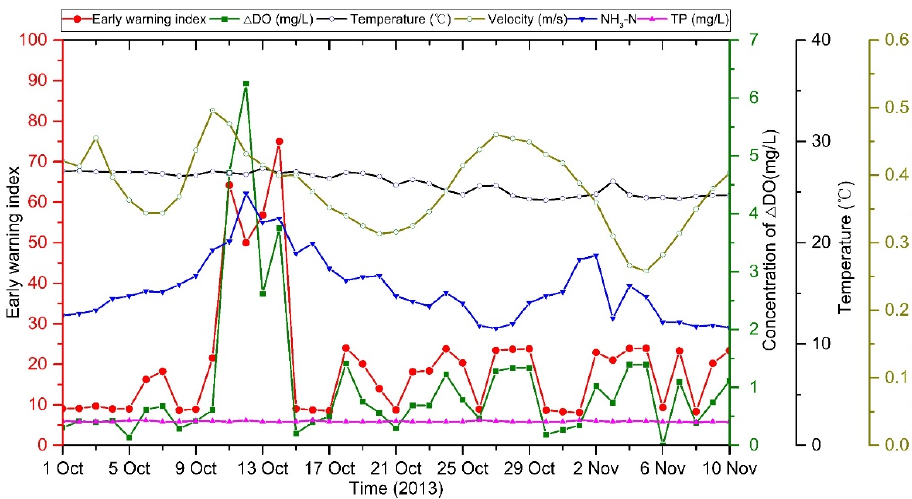
Figure 7. Time series of the input variables and the warning index of the DC station during the false alarm period in October 2013. alarm period in October 2013.